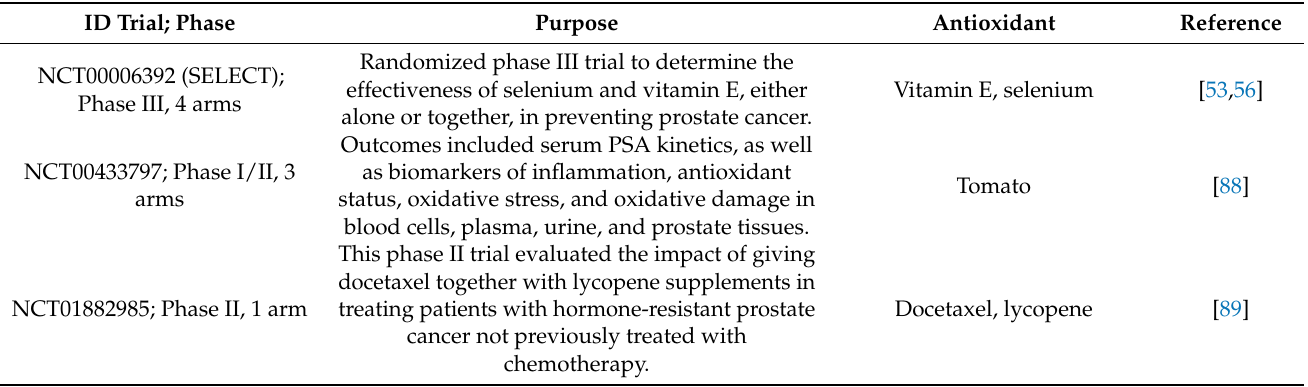
Table 1. Clinical trials that recently investigated the role of antioxidants in the PCa, as discussed in the